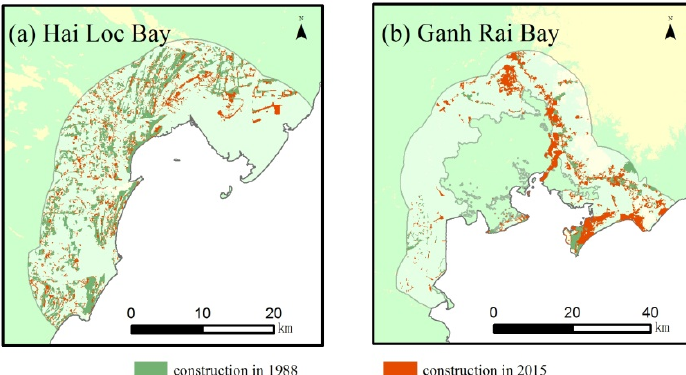
Figure 12. Spatial distribution of construction land in Hai Loc Bay and Ganh Rai Bay. ( a ) Hai Loc Bay; ( b ) Ganh Rai Bay.